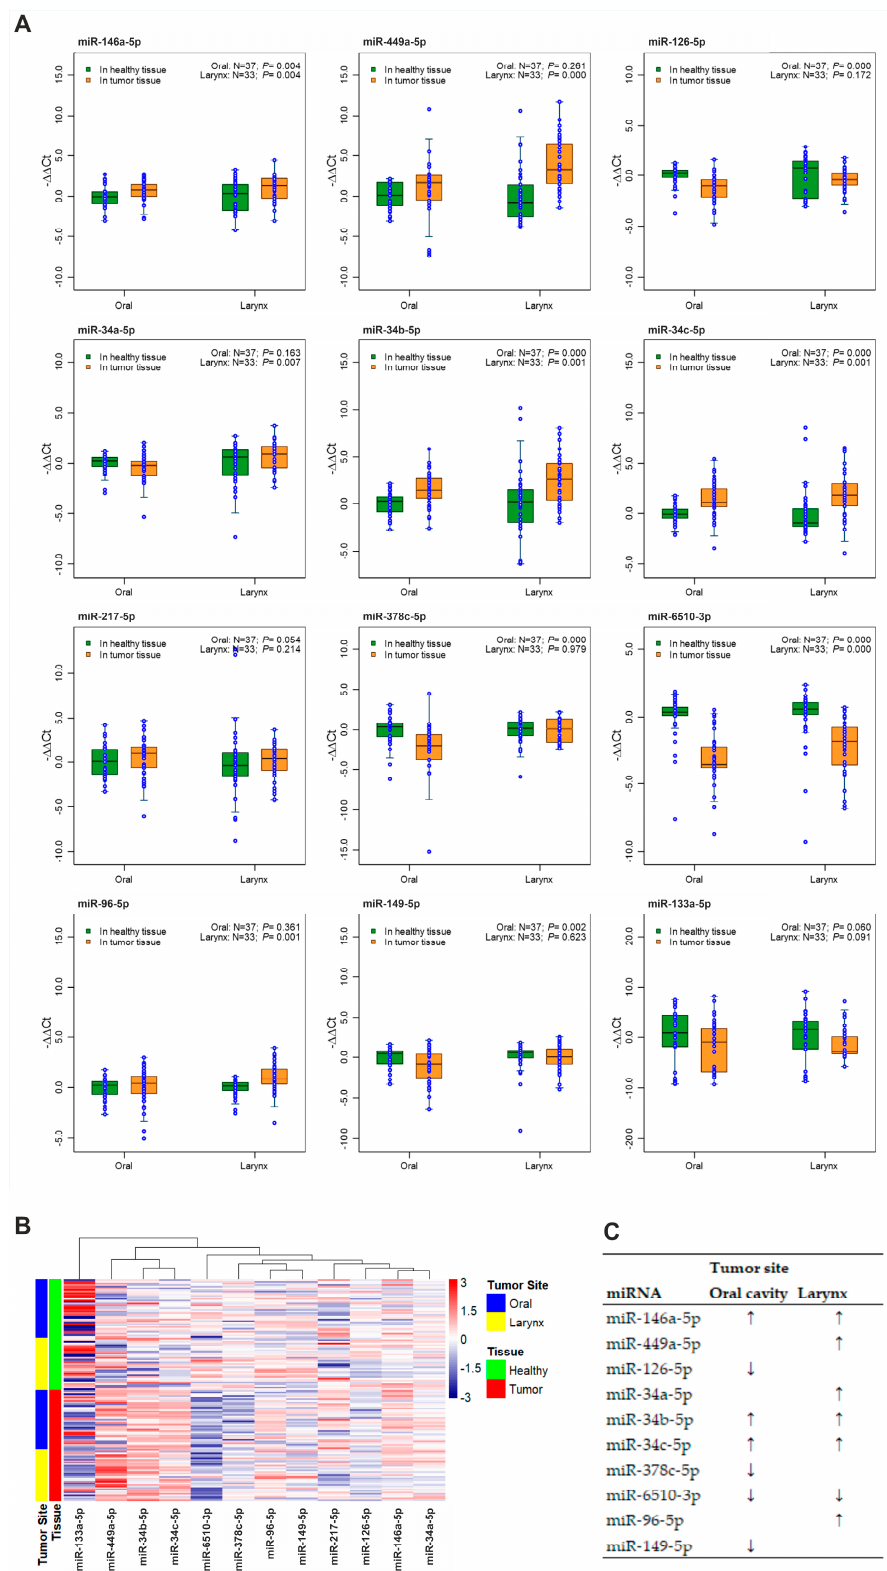
Figure 2. Expression of miRNAs in tumor tissue and nearby healthy tissue of HNSCC patients. ( A ) Boxplots showing the comparison of expression of 12 miRNAs between tumor tissue and nearby healthy tissue in the oral cavity, and larynx. Expression was calculated using − ∆∆ Ct method;